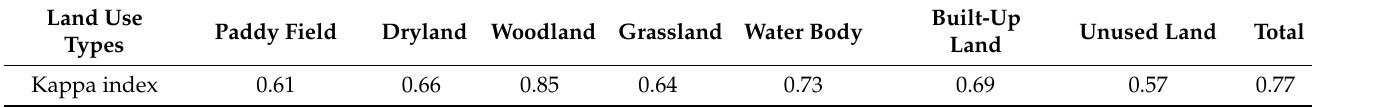
Table 5. Kappa indexes between two land-use maps in